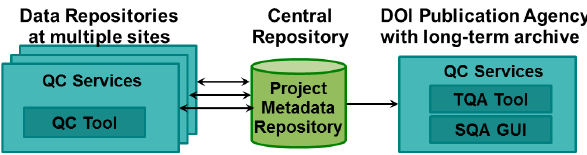
Fig. 1. Infrastructure components of a distributed quality assess- ment